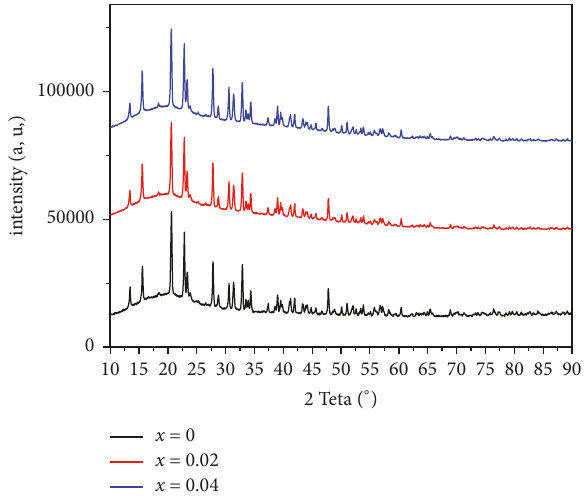
Figure 3: XRD patterns of LiGd (1